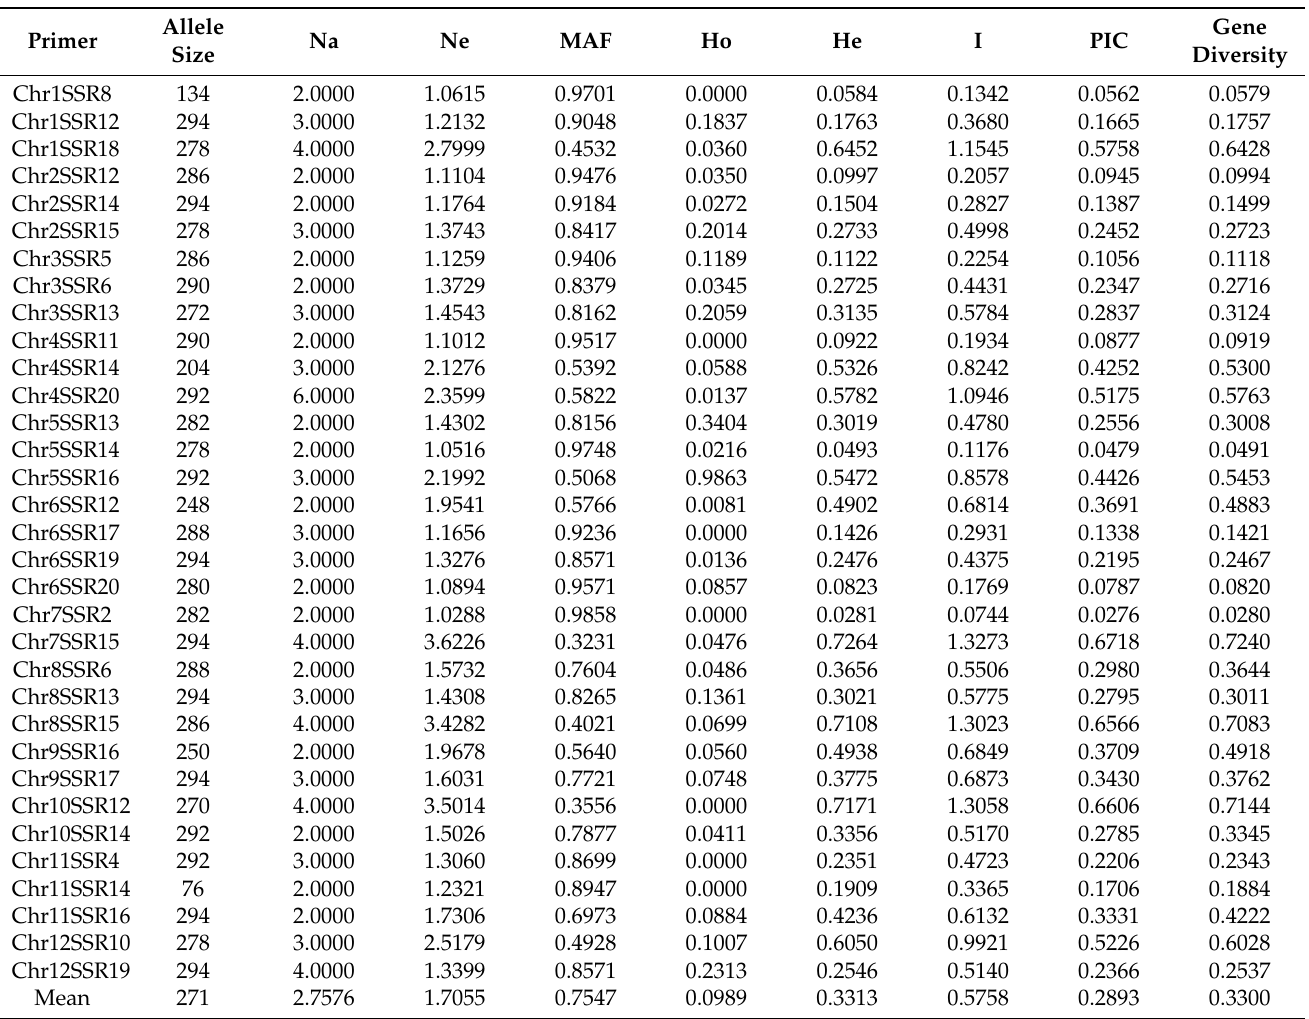
Table 2. Polymorphism analysis of the 147 C. frutescens accessions with SSR